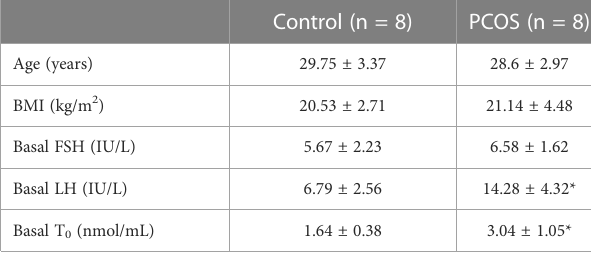
TABLE 1 Biochemical indexes from controls and PCOS